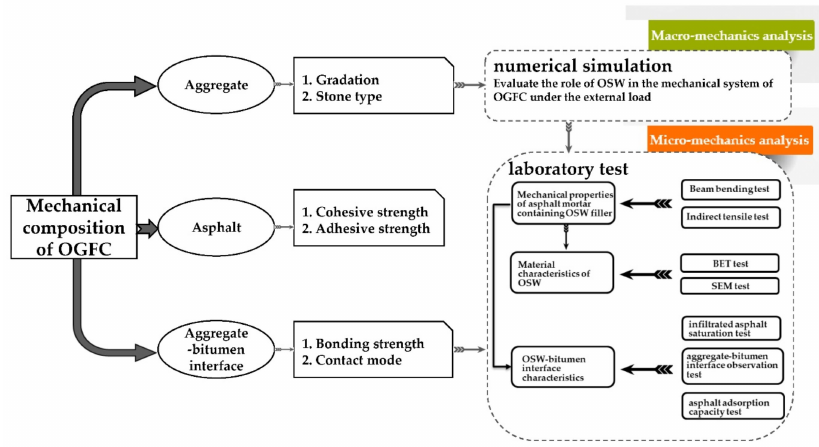
Figure 2. Main procedure of this research. OGFC: open grade friction